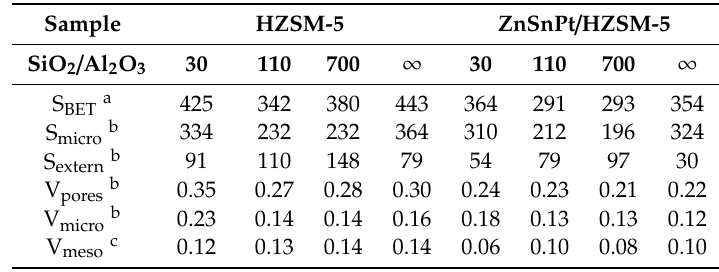
Table 1. Textural properties of the parent and Zn–Sn–Pt modified defective MFI zeolites with different SiO 2 /Al 2 O 3 ratios.